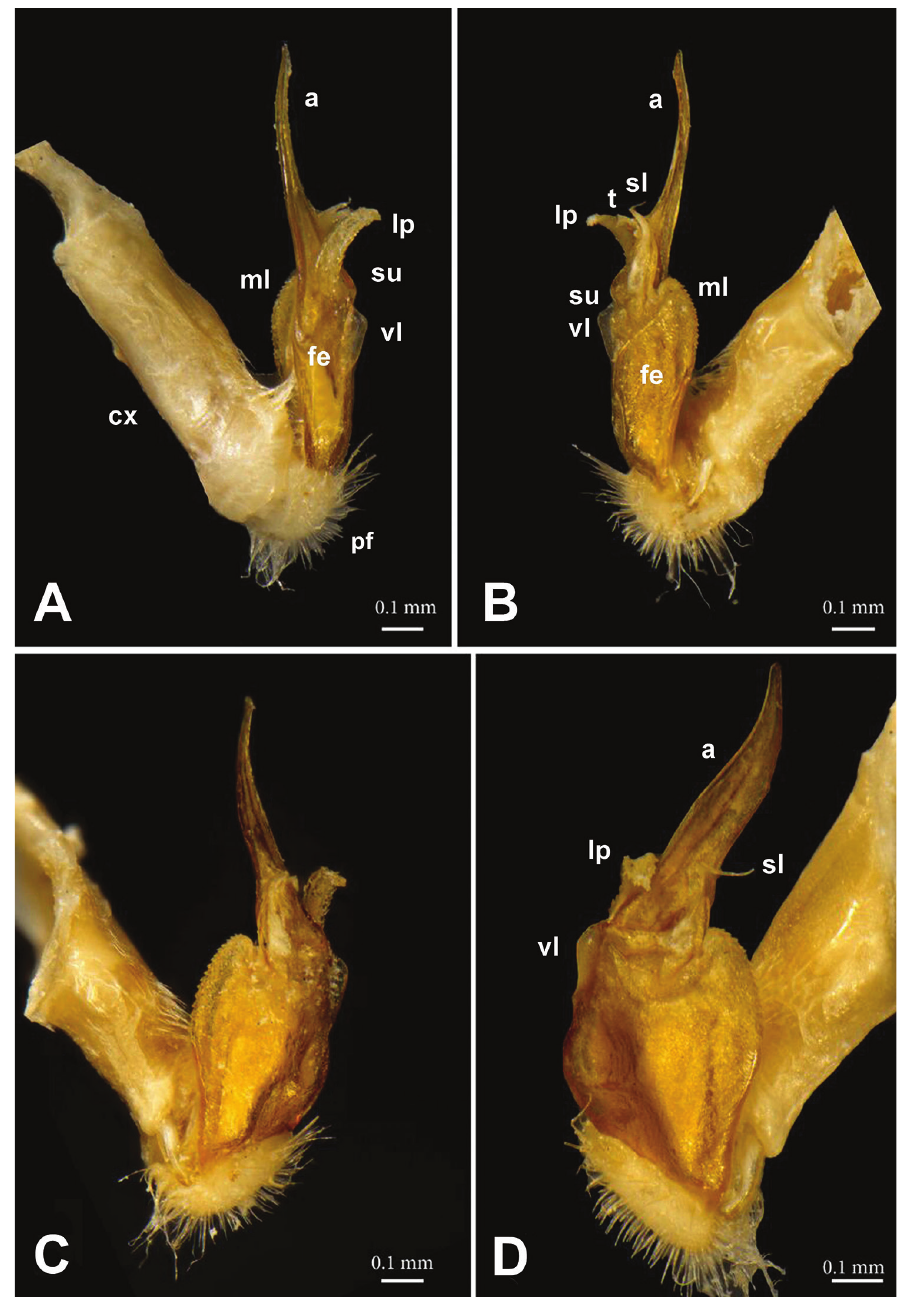
Figure 2. Annamina xanthoptera Attems, 1937, ♂ paralectotype (NHMW), right ( A, B, D ) and left ( C ) gonopods, A lateral B mesal C ventromesal and D subventral views, respectively (cx = coxite; fe = femo- rite; pf = prefemoral part; vl = ventral lobe; ml = mesal lobe; su = postfemoral sulcus; lp = lateral process; a = apical process; sl = solenomere; t = solenophore